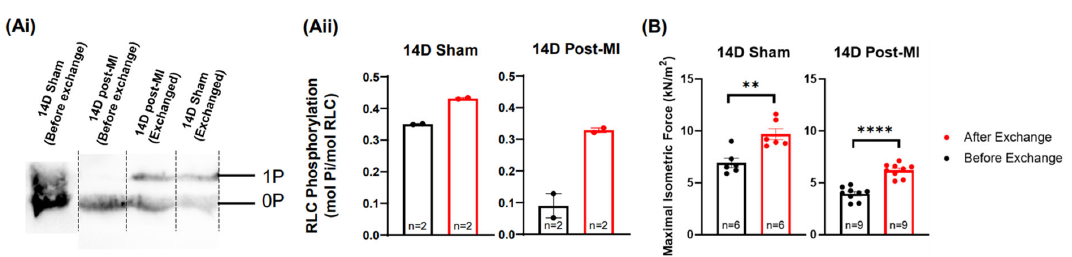
Figure 5. Potential for RLC phosphorylation in terms of muscle recovery. ( Ai ) Blot images of RLC extracted papillary muscle fibres under two treatments: 14D sham and post-MI permeabilized fibres (control) and 14D post-MI and sham permeabilized fibres exchanged with phosphorylated RLCs. Each lane contains protein samples extracted from five papillary fibre segments. ( Aii ) Bar graph representation of phosphorylation levels for the above-mentioned groups. Unpaired one-tailed Mann–Whitney test was performed for the respective groups, but no significant difference was detected between the ranks. Note: ‘ n ’ refers to the technical replicates. Two mice were used for post-MI groups and one mouse was used for sham group. ( B ) Bar graph of maximal isometric force of the above-mentioned groups. Unpaired one-tailed t -test was conducted to test for statistically significant differences. Three mice were used for each group. Note: ‘ n ’ refers to the number of papillary segments used for data collection; ** p < 0.01, **** p <